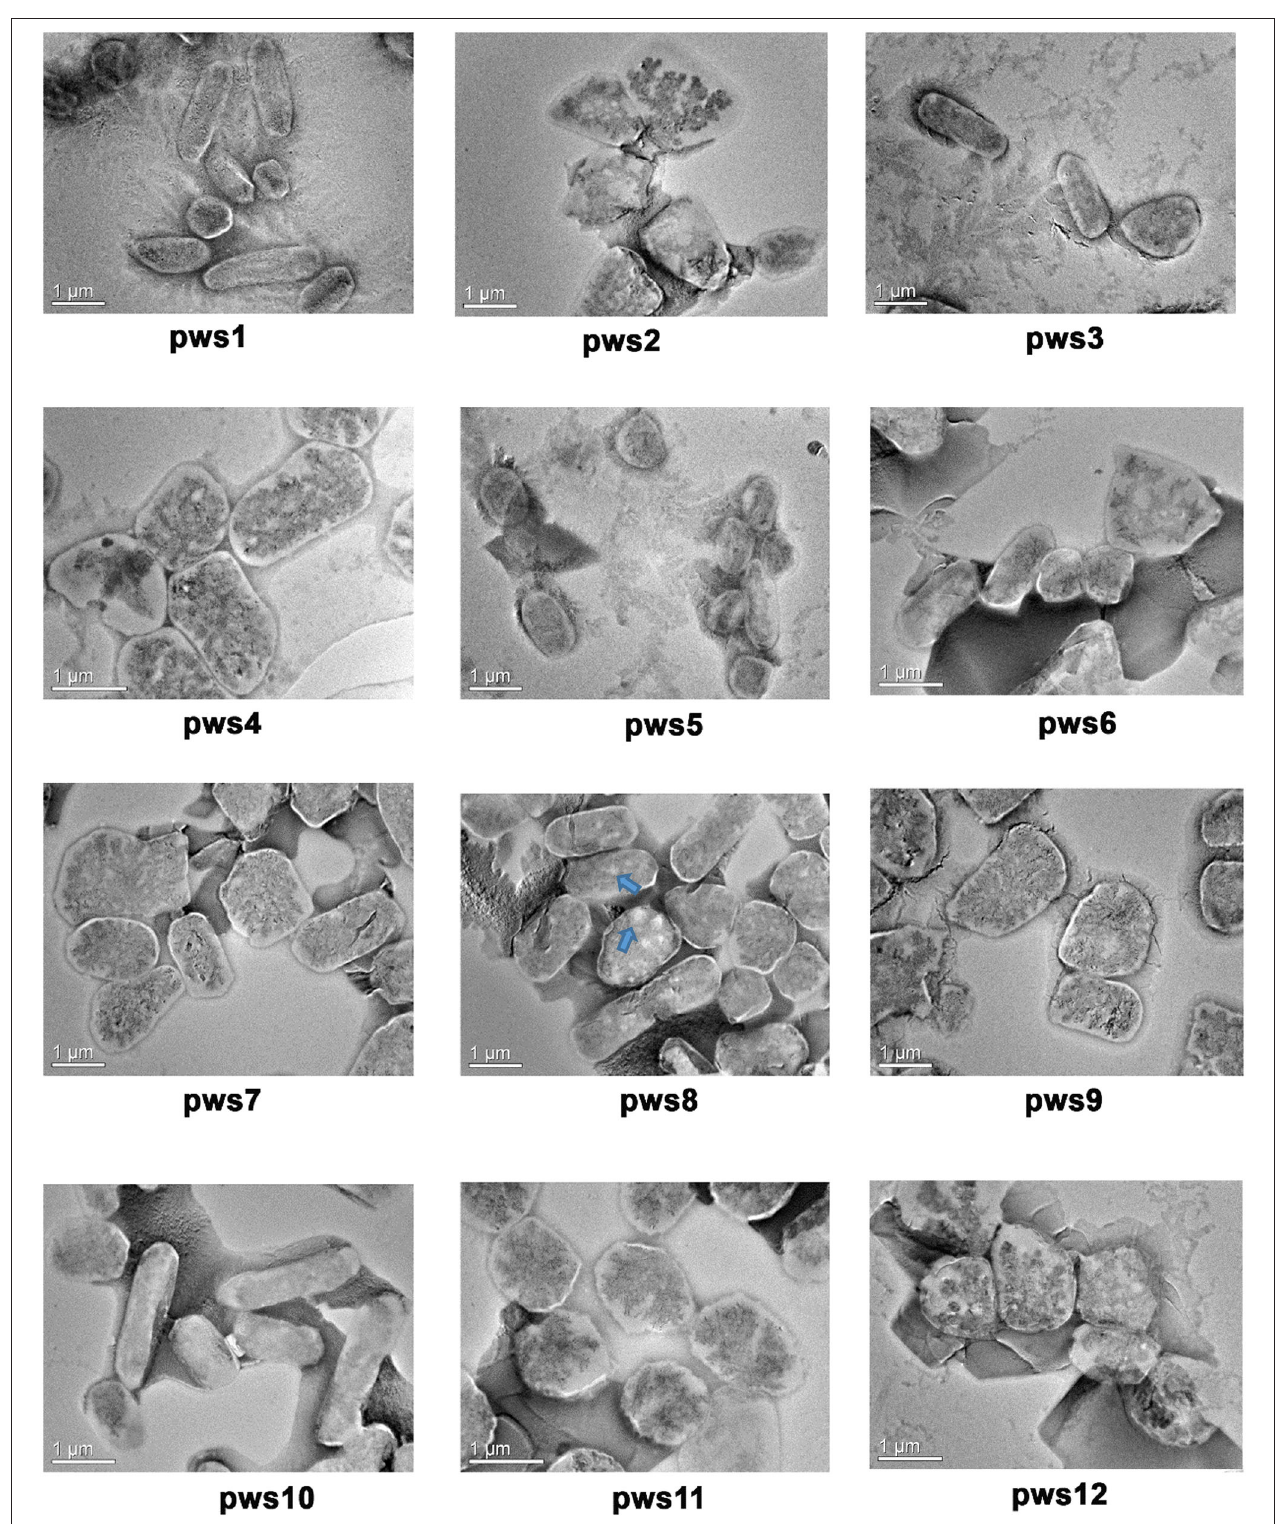
FIGURE 1 | Transmission electron microscopy images of pws isolates. TEM images reveal polymorphic morphology in the haloarchaeal isolates. Blue arrows indicate the presence of gas vacuoles.